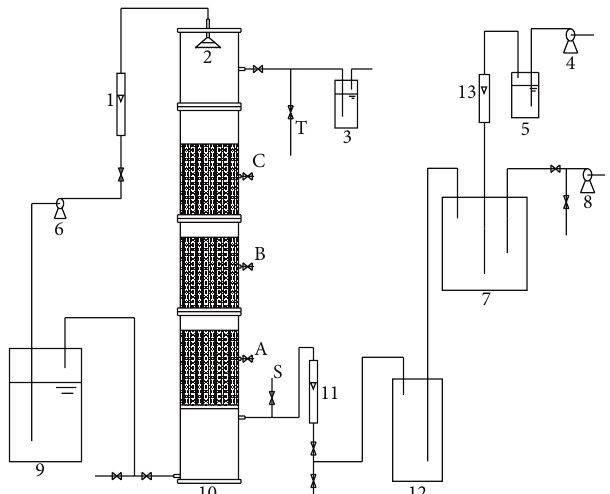
Figure 1: Biotrickling filter set-up and technological process (1: liquid-flow meter; 2: sprinklers; 3: absorption bottle; 4: air pump; 5: ethanethiol reservoir; 6: peristaltic pump; 7: mixing gas tank; 8: compressor; 9: nutrient recirculation tank; 10: biotrickling filter; 11 and 13: gas-flow meter; 12: buffered gas-bottle; S, A, B, C, T: sampling